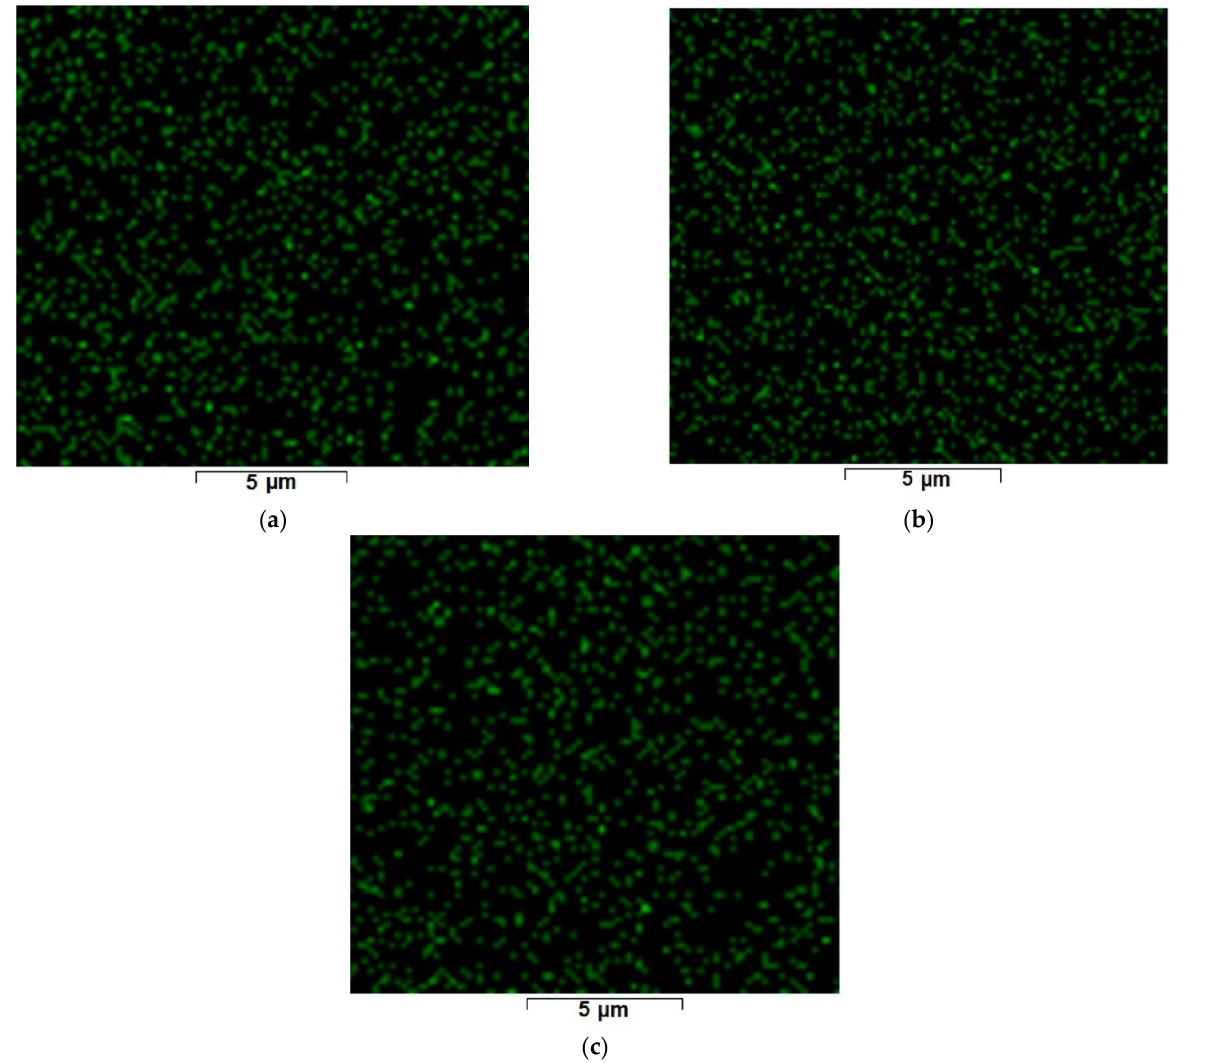
Figure 9. The energy dispersive spectroscopy analysis (EDAX) for the osmium nanoparticles-polypropylene hollow fibers composite membrane before ( a ); and after reduction ( b ); or oxidation ( c ) processes.